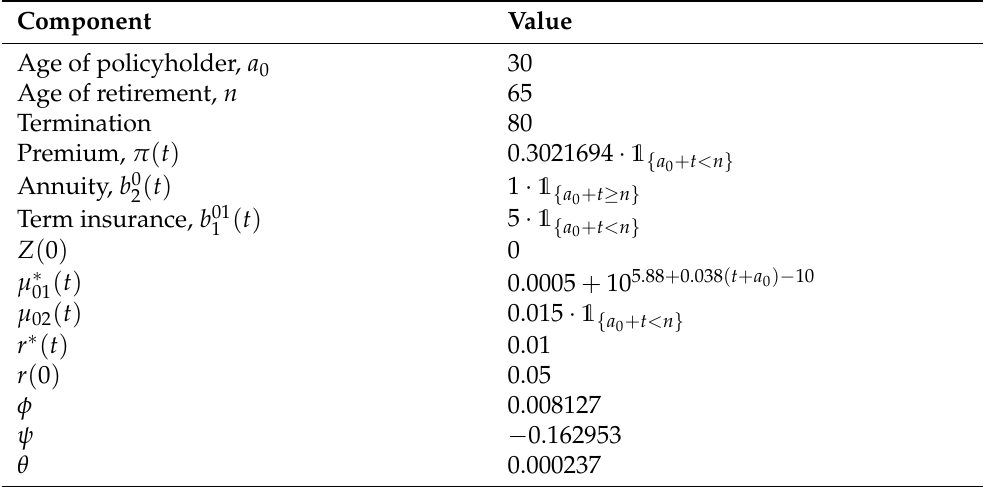
Table 1. Components in the numerical example.